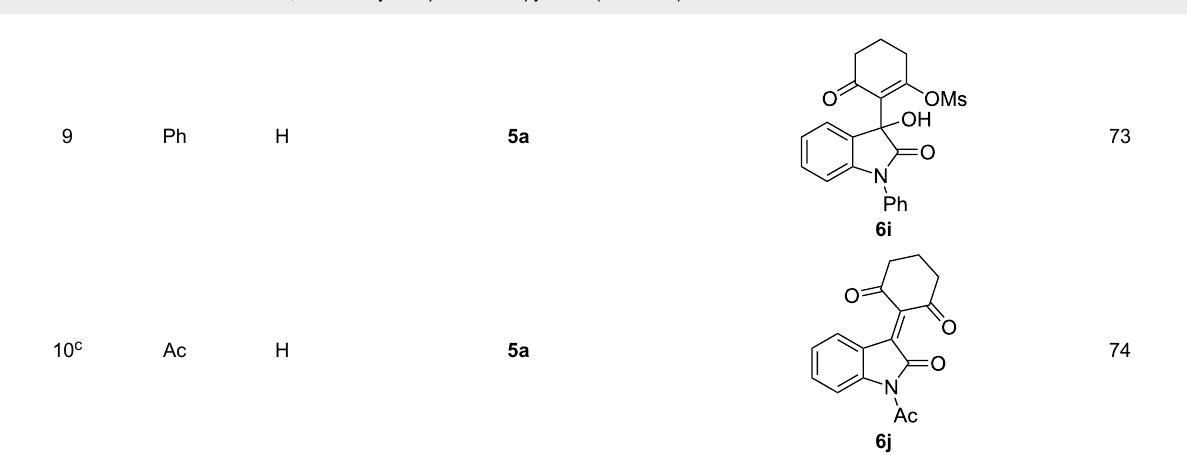
Table 1: Reaction of isatins 4 and 1,3-dicarbonyl compounds 5 in pyridine. (continued)